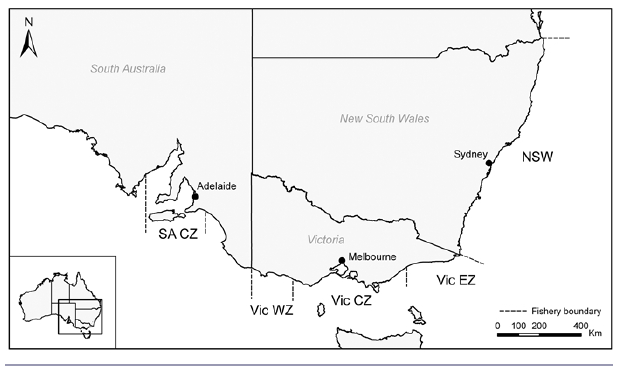
Fig. 1 . Map showing the distribution of the abalone ( Haliotis spp.) fisheries studied in southeastern Australia. SACZ = South Australian Central Zone, VicWZ = Victorian Western Zone, VicCZ = Victorian Central Zone, VicEZ = Victorian Eastern Zone, NSW = New South Wales.